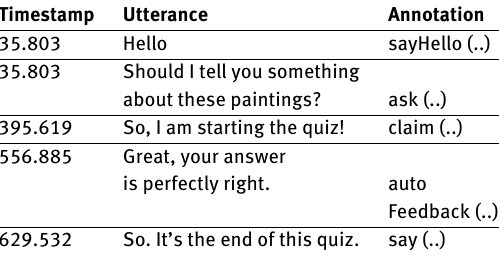
Table 1: Sample annotation of traces. The “Utterance” in the second column at the timestamp (in seconds) from the beginning of the interaction mentioned in the column “Timestamp” is annotated with the speech act in the column “Annotation”. The (..) represents the operator parameters.